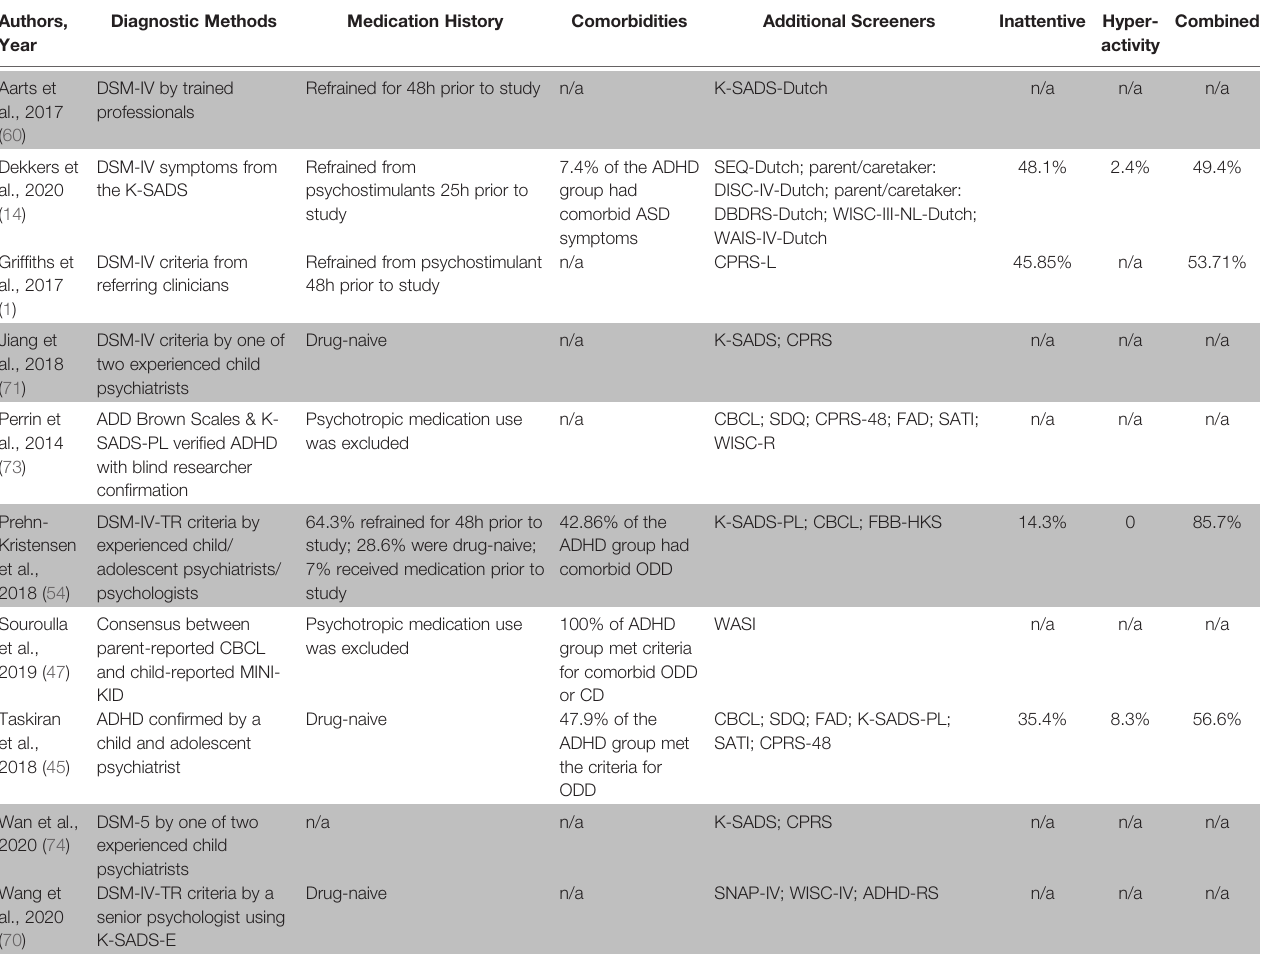
TABLE 2 | Summary of ADHD Diagnostic Methods and Relevant Study